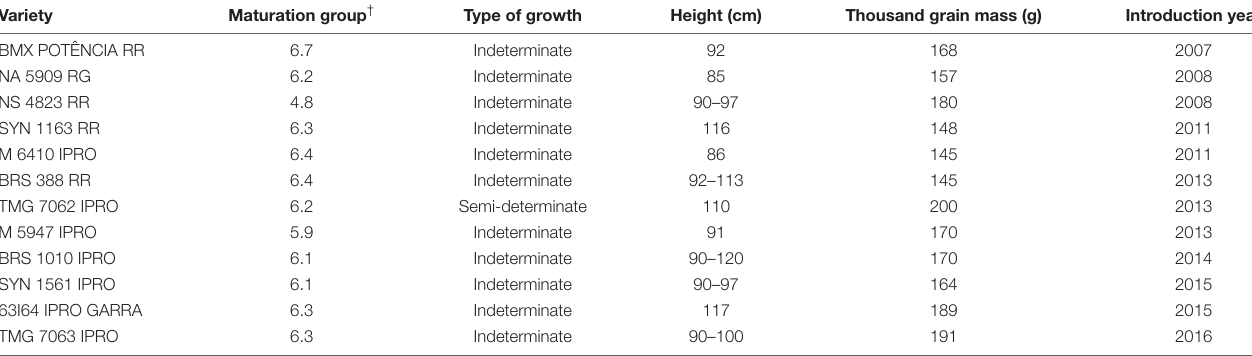
TABLE 1 | Soybean varieties studied, maturation groups, type of growth, height, thousand grain mass, and introduction year. Variety